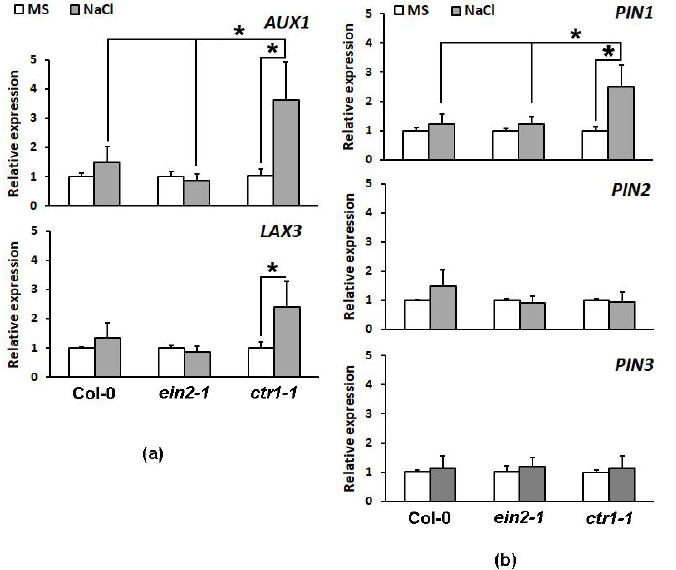
Figure 4. Relative expression of the auxin influx AUX1 and LAX3 ( a ), and efflux carrier genes PIN1 , PIN2 and PIN3 ( b ) in the roots of the wild type Col-0, ethylene-insensitive ein2-1 , and constitutive signaling mutant ctr1-1 grown on ½ MS (white bars) and media supplemented with 100 mM NaCl (grey bars) at 14 DAG (day after germination). Asterisks depict significant differences compared to the salt-stressed wild type or compared to the control within the same genetic background (One-way ANOVA, p ≤0.05, n ≥3 datasets).